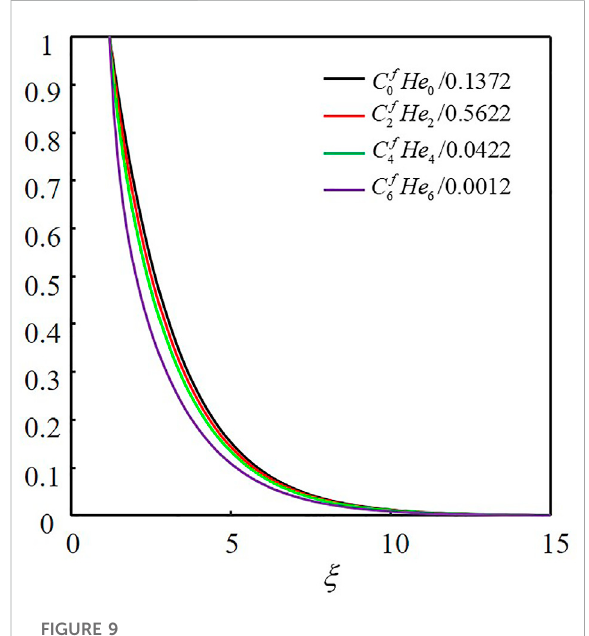
Curves of the combination coef fi cient of various order with the distance. The curves are normalised relative to their maximum value at ξ =